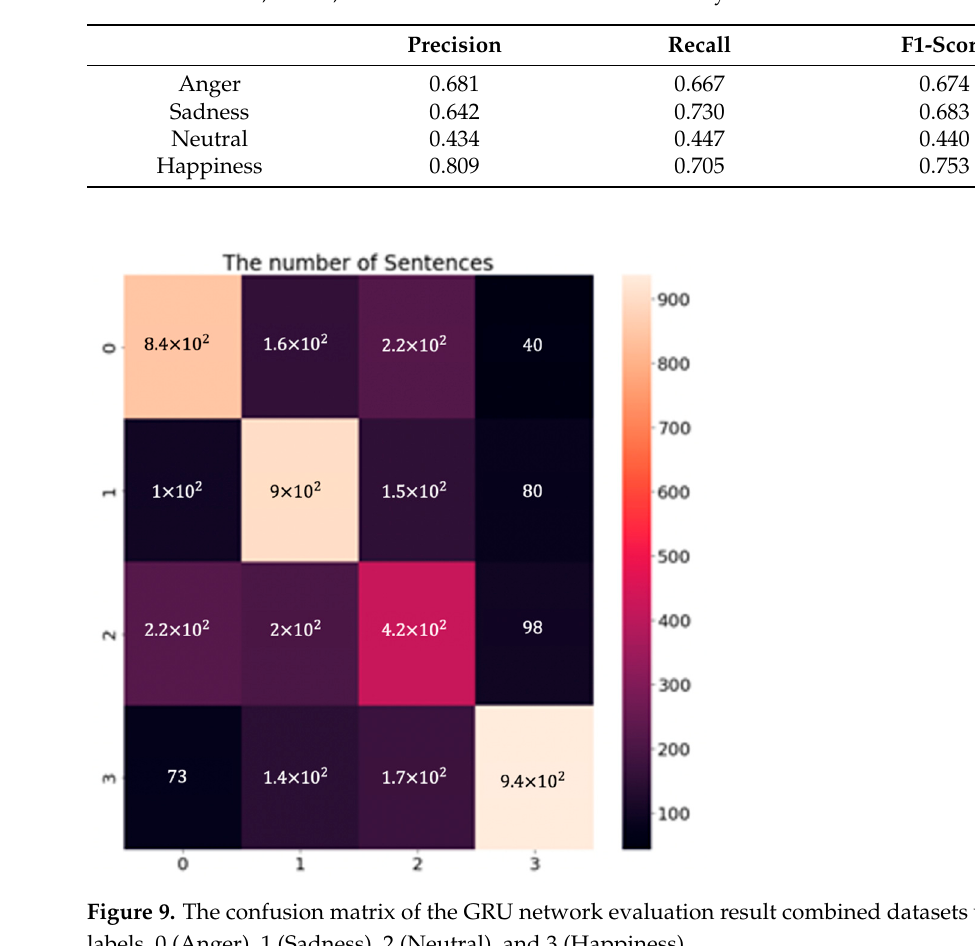
Table 5. Performance comparison of various models trained by the Instagram-crawling dataset.